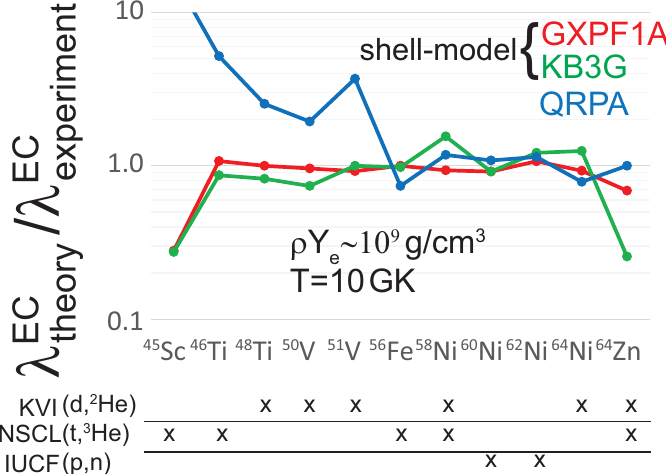
Figure 1. Comparison of electron captures rates, calculated from experimental GT + data and distribu- tions, derived from the large-scale shell model calculations with two different interactions (KB3G [37] and GXPF1 [38]) and from a Quasiparticle Random Phase Approximation (QRPA) approach [36]. See text for details. The conditions correspond to the early stage of the collapse where the capture rates are sensitive to details of the GT + distribution. The shell model rates have been quenched with typical factor of ( 0.74 ) 2 , as derived in [30]. ρ Y e and T denote the electron density and temperature, respectively. KVI, UCSL and IUCF stay for the laboratories at which the experiments were performed. Taken from [39] with